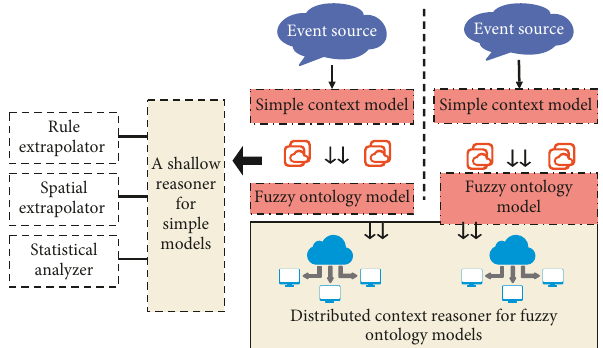
Figure 2: Overall implementation diagram of contextual reasoning.